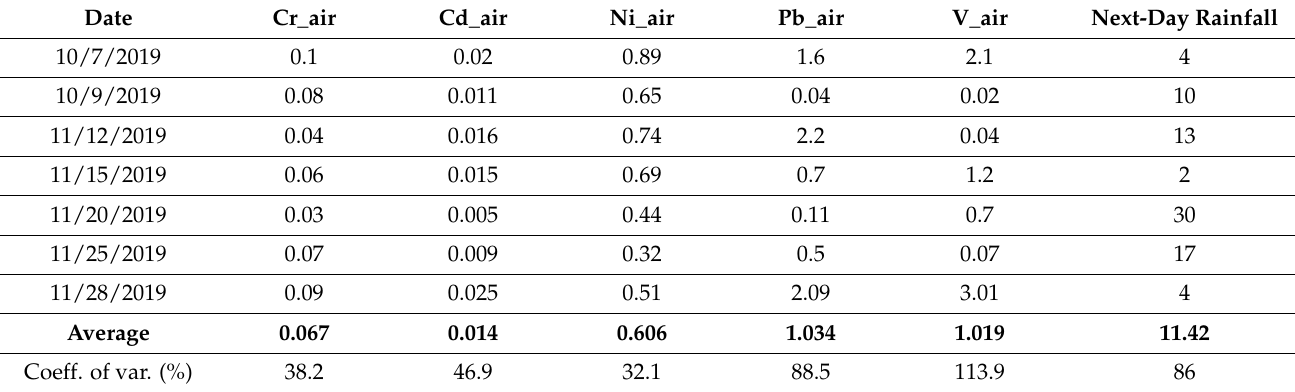
Table 3. Concentrations of the heavy metals (ng m − 3 ) from PM 2.5 recorded before the rainfall events (mm).